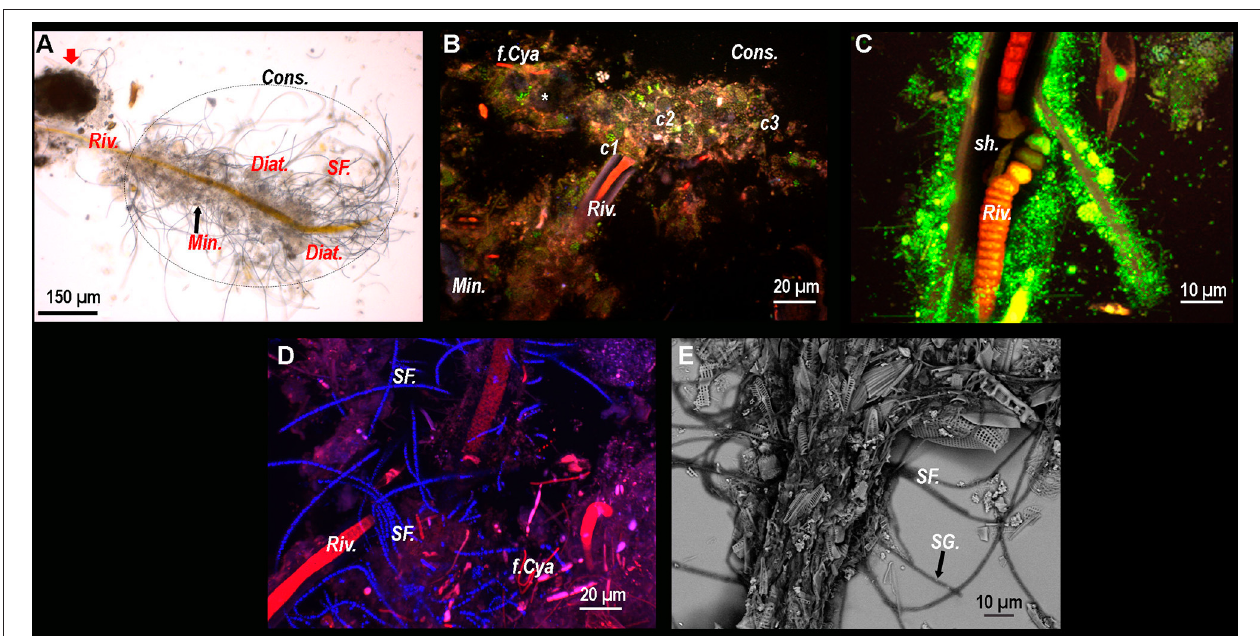
FIGURE 3 | (A) Optical microscopy image of a Rivularia filament ( Riv. ) with which numerous microorganisms are associated, hence suggesting the presence of a consortium ( Cons. ) (dotted circle). A large mineral aggregate is also visible near the filament (red arrow). Sulfur filaments ( SF. ), diatoms ( Diat. ) and mineral grains ( Min. ) can also be observed around the filament. From (B–D) : Composite CSLM images obtained over an integrated depth of 50 µ m by concomitant excitations at 405, 488, and 543nm and collection between 425 and 475nm, 500 and 530nm, and 560 and 660nm, respectively. (B) Composite CLSM image of a consortium surrounding a Rivularia filament distinguished in red due to its photosynthetic pigments. Inside the consortium, abundant cocci-shaped cells are observed thanks to Syto ® 9 staining (green) ( c1 , c2, and c3 ). Minerals appear in light blue due to laser reflection (white asterisk). Other filamentous cyanobacteria ( f.Cya ) are observed. (C) High magnification composite CLSM image of a Rivularia filament where cells are visible (in red) inside the sheath ( sh. ), which is covered by a myriad of Syto ® 9-stained cells. (D) Detail of a Rivularia filament associated with sulfur-bearing bacterial filaments (bright blue dots due to laser reflection). (E) Magnified SEM image in backscattered electron mode showing a Rivularia filament and the associated sulfur-bearing filaments (black arrow) with sulfur grains ( SG. ) appearing as bright dots. (A,B,D,E) were obtained on BP13 mat samples, while (C) was observed on BP15 mat sample after laser